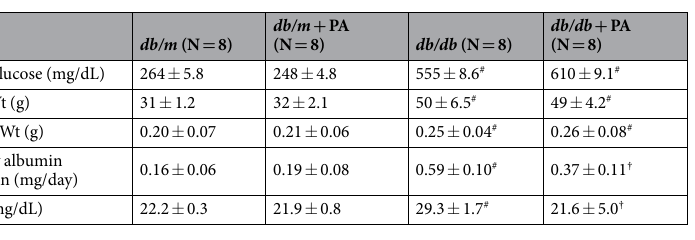
Table 2. Body weight, kidney weight, and 24-h urinary albumin excretion in type II diabetes mellitus (DM) mice. C, control; PA, periostin-binding DNA aptamer; BUN, blood urea nitrogen. # P < 0.05 vs. db/m; † P < 0.05 vs.